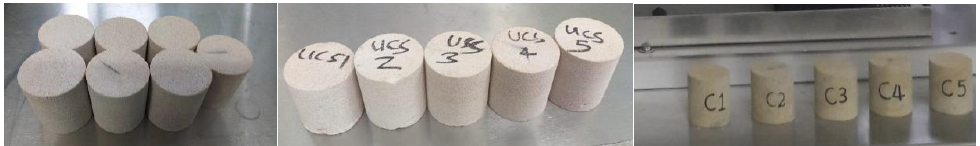
Figure 2. Appearance of the sandstone samples for the UCS test: dry samples (right), wet samples (middle), for the AVS test (left).